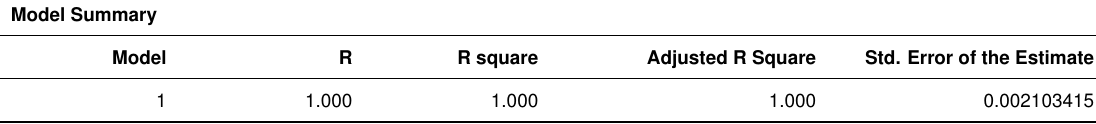
Table 7. Calculation of sensitivity using multiple regression